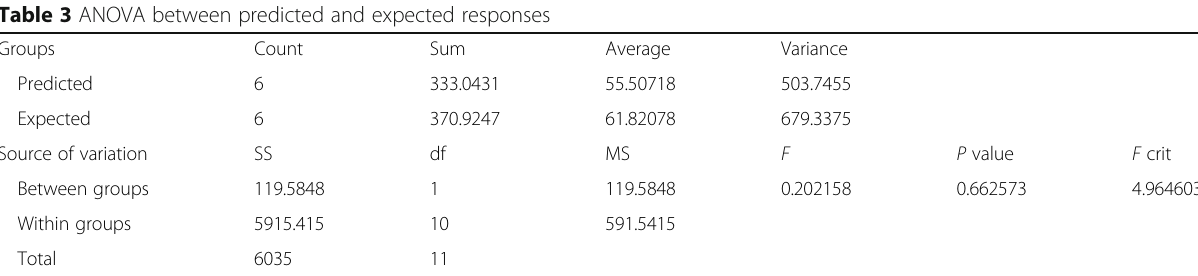
Table 3 ANOVA between predicted and expected responses Groups Count Sum Average Variance